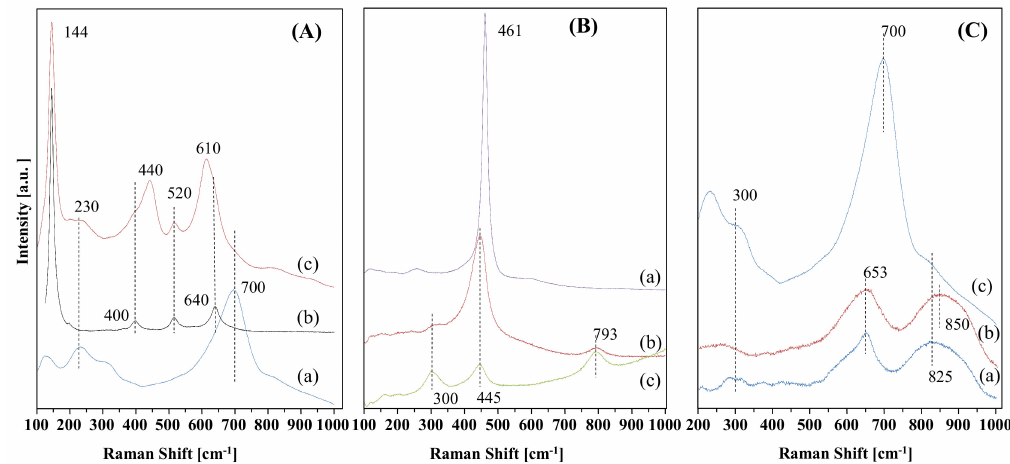
Figure 4. Raman spectra of the samples: ( A ) (a) pristine Nb 2 O 5 , (b) bare TiO 2 and Nb 2 O 5 -TiO 2 binary material; ( B ) three different measures on the same sample Nb 2 O 5 -CeO 2 binary material and ( C ) (a) and (b) two different measures on the same sample Nb 2 O 5 -ZrO 2 binary material and (c) pristine Nb 2 O 5